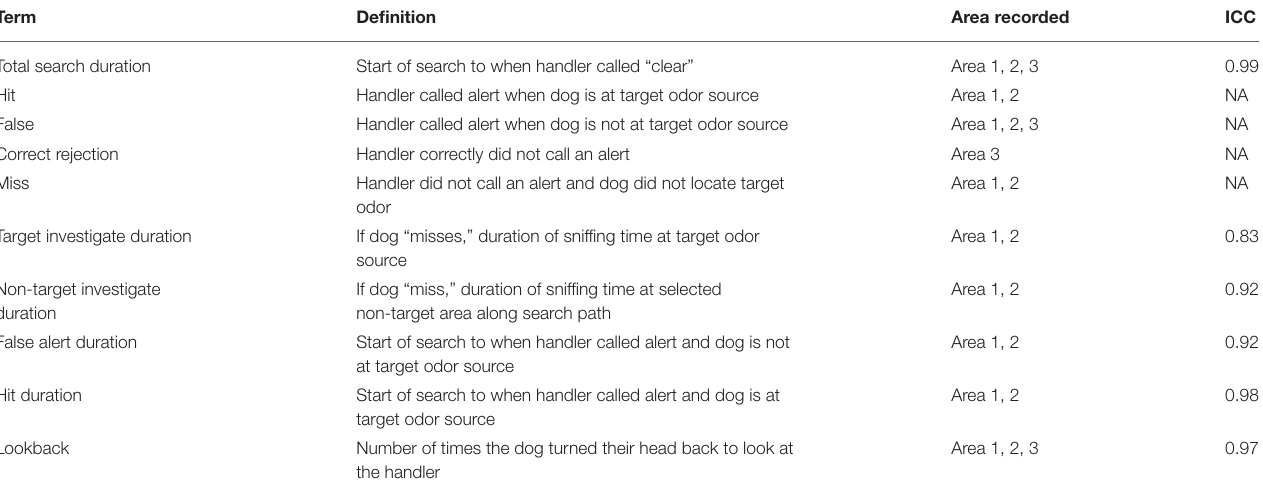
TABLE 1 | Data recorded during three area searches.